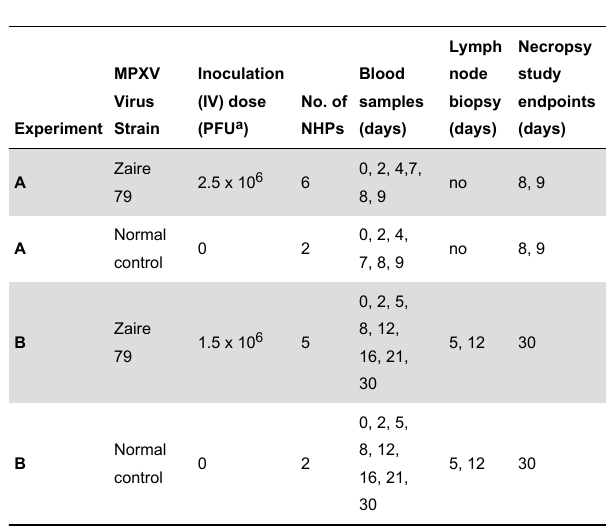
Table 1. Overview of experimental MPXV IV challenge protocols for experiments A and